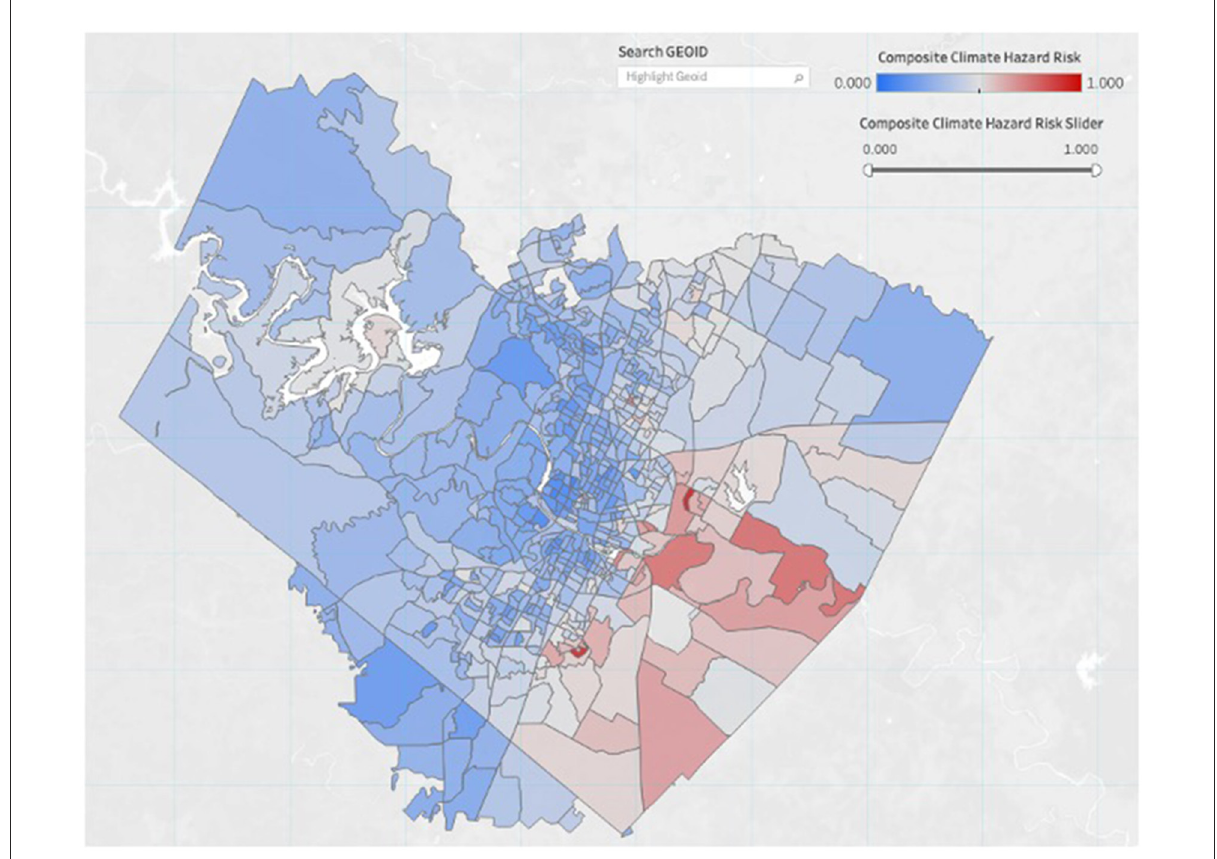
FIGURE3 Multi-hazard risk index for Austin, Texas (for more on this see austinindicators.org and Bixler et al., 2021b).